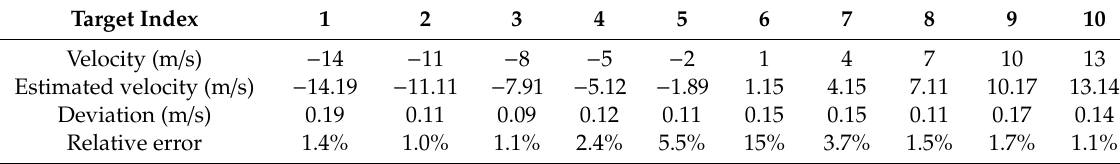
Table 3. Slant-range velocity estimation results for di ff erent targets with the same